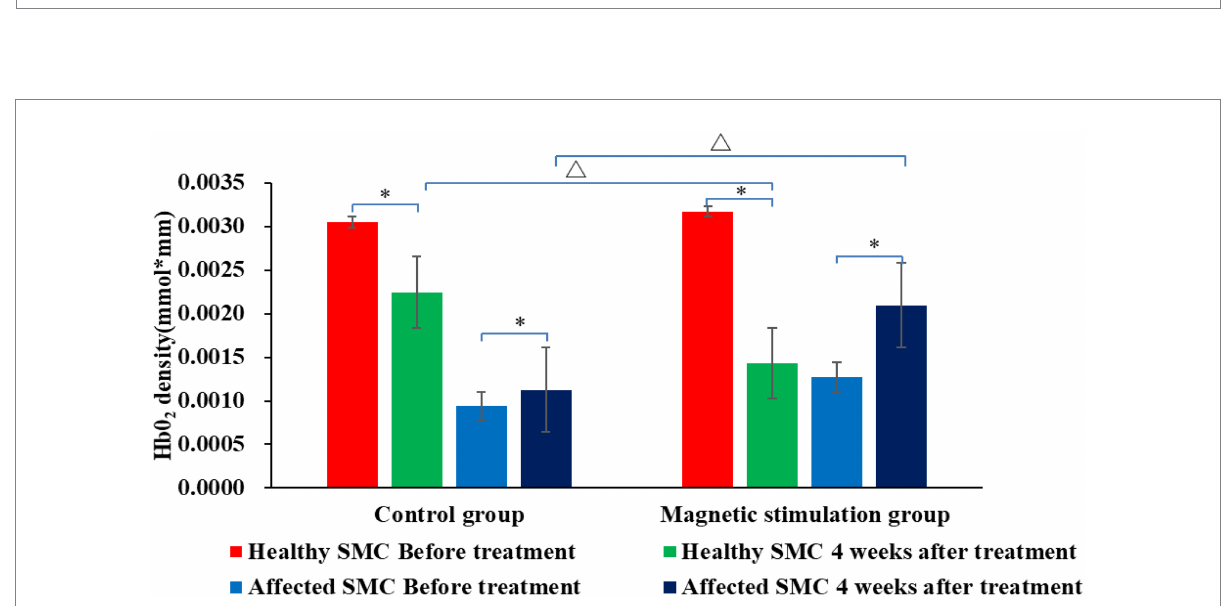
FIGURE 7 Comparison of HbO2 content in SMC area of the two groups before and after treatment. * p < 0.001; ∆ p < 0.001.